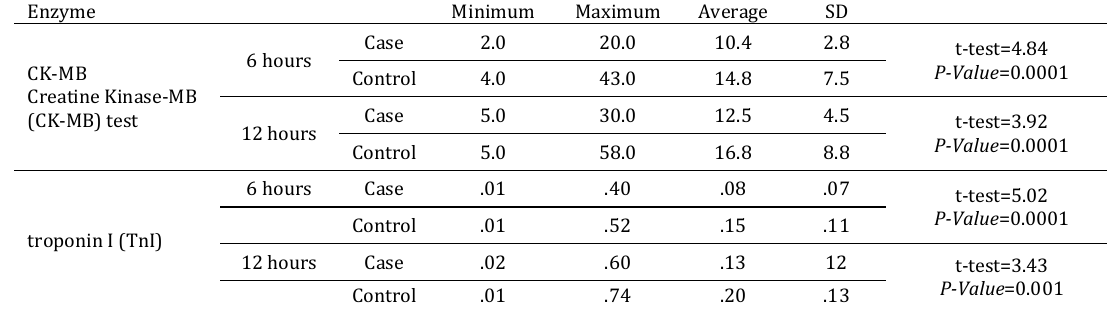
Table 2. Enzyme level after coronary angioplasty